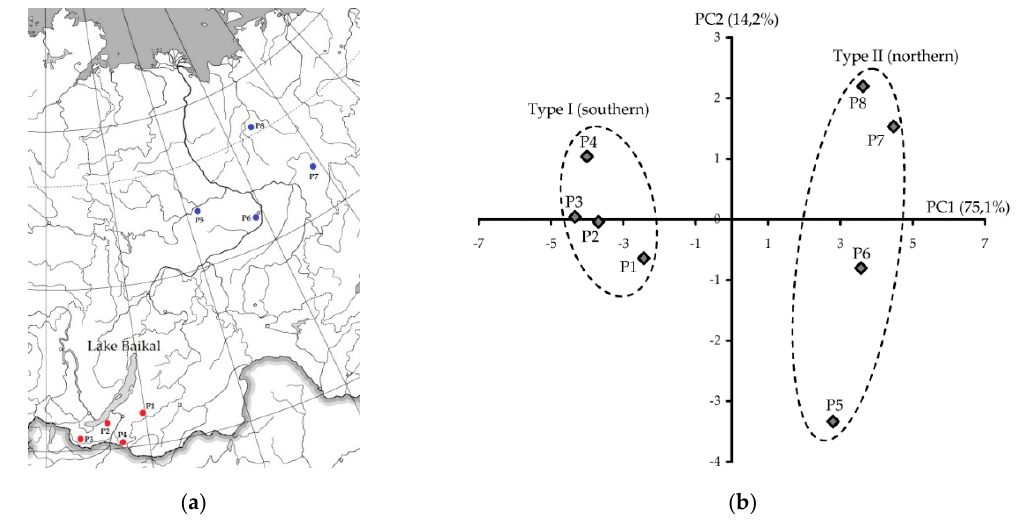
Figure 2. ( a ) Location of Galeopsis bifida populations. ( b ) Results of principal component analysis (PCA) used the content of eighteen compounds in G. bifida leaves from eight Siberian populations. P1–P8—number of G. bifida population.